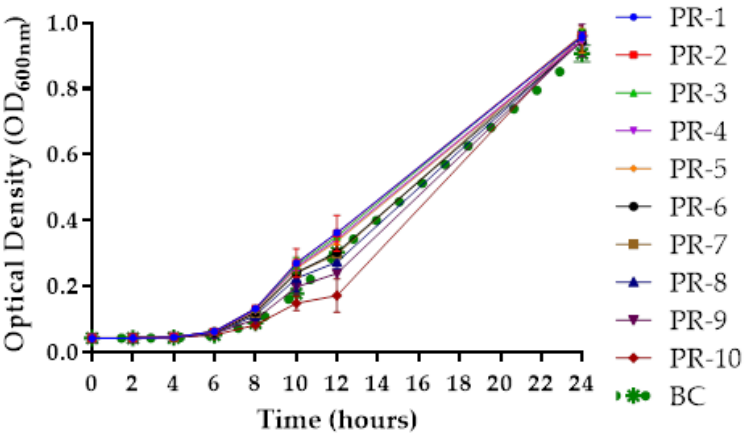
Figure 5. Growth curve of phage-resistant A. hydrophila strains during 24 h, with optical density (OD) readings at 600 nm. PR-1-PR10, phage resistant bacteria strains; BC, bacteria sensitive to phage AH-1. Values represent the mean of three three independent experiments and error bars represent the standard